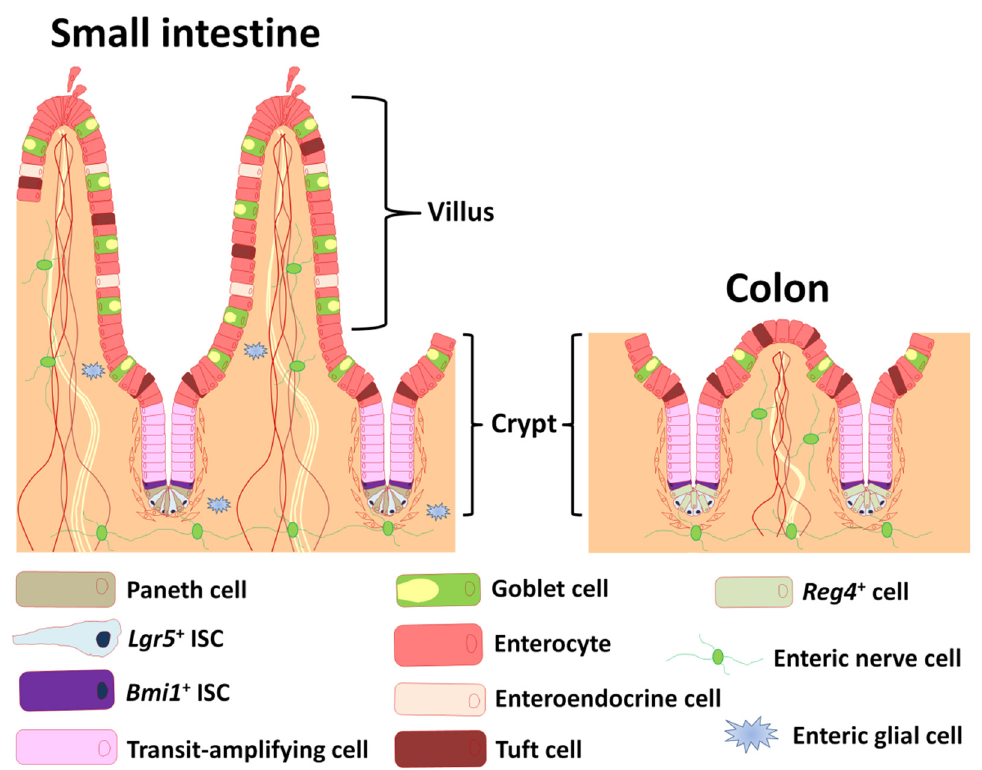
Figure 1. Depiction of the anatomy of intestinal epithelium and enteric nervous system. Cartoon depiction of small intestinal and colonic epithelium showing differentiated cell types, transit-amplifying cells, and enteric nerve and glial cells. Lgr5: leucine-rich repeat-containing G-protein coupled receptor 5, Bmi1: B-cell-specific Moloney murine leukemia virus integration site 1, Reg4: regenerating islet-derived protein 4.